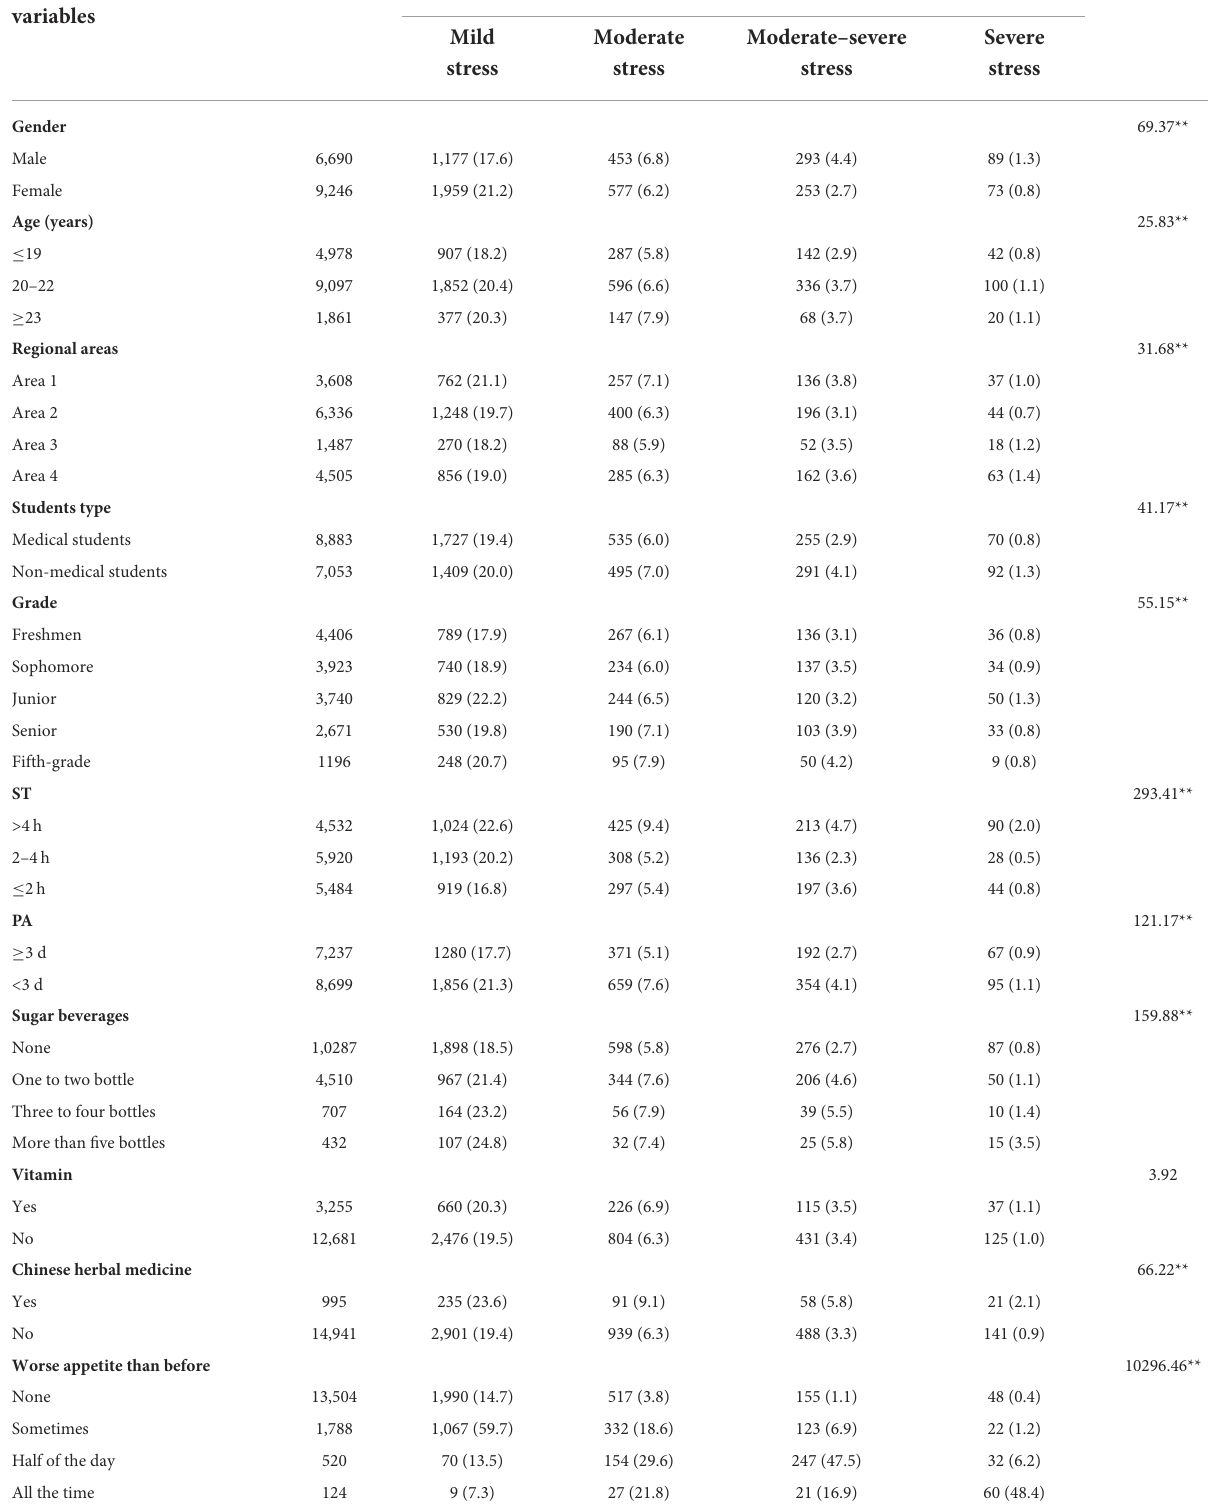
TABLE 1 The prevalence between health behaviors and depression among college students.